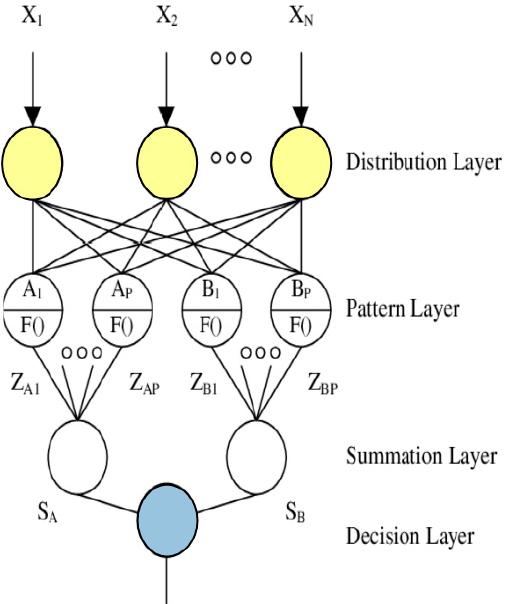
Figure 4. Probabilistic neural network layout.